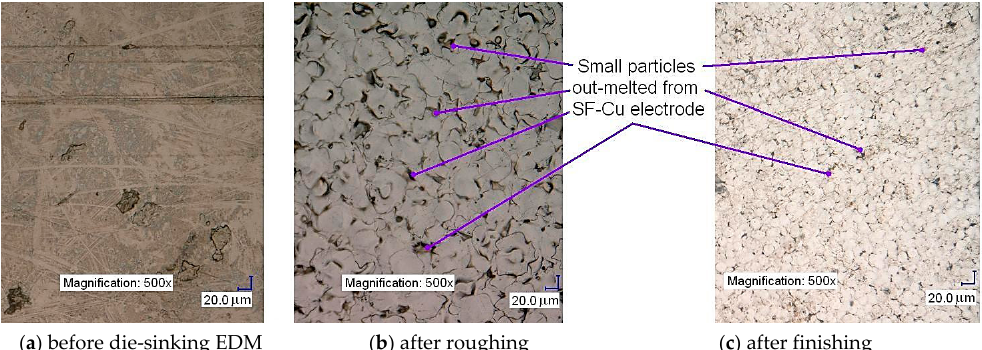
Figure 4. Characteristic change of relief and microstructure of the surface of the material EN X32CrMoV12 ‐ 28 after die ‐ sinking EDM, roughing, and finishing in comparison to the source X32CrMoV12-28 after die-sinking EDM, roughing, and finishing in comparison to the source material, material, magnification 500×. magnification 500 ×